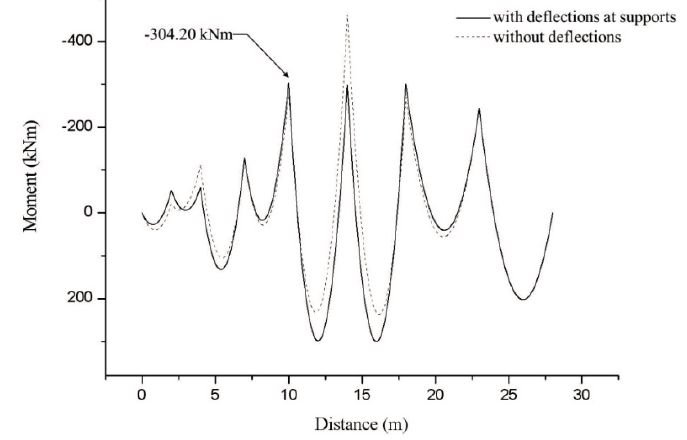
Figure 10. Bending moment diagram for an 8-span beam for estimation of maximum